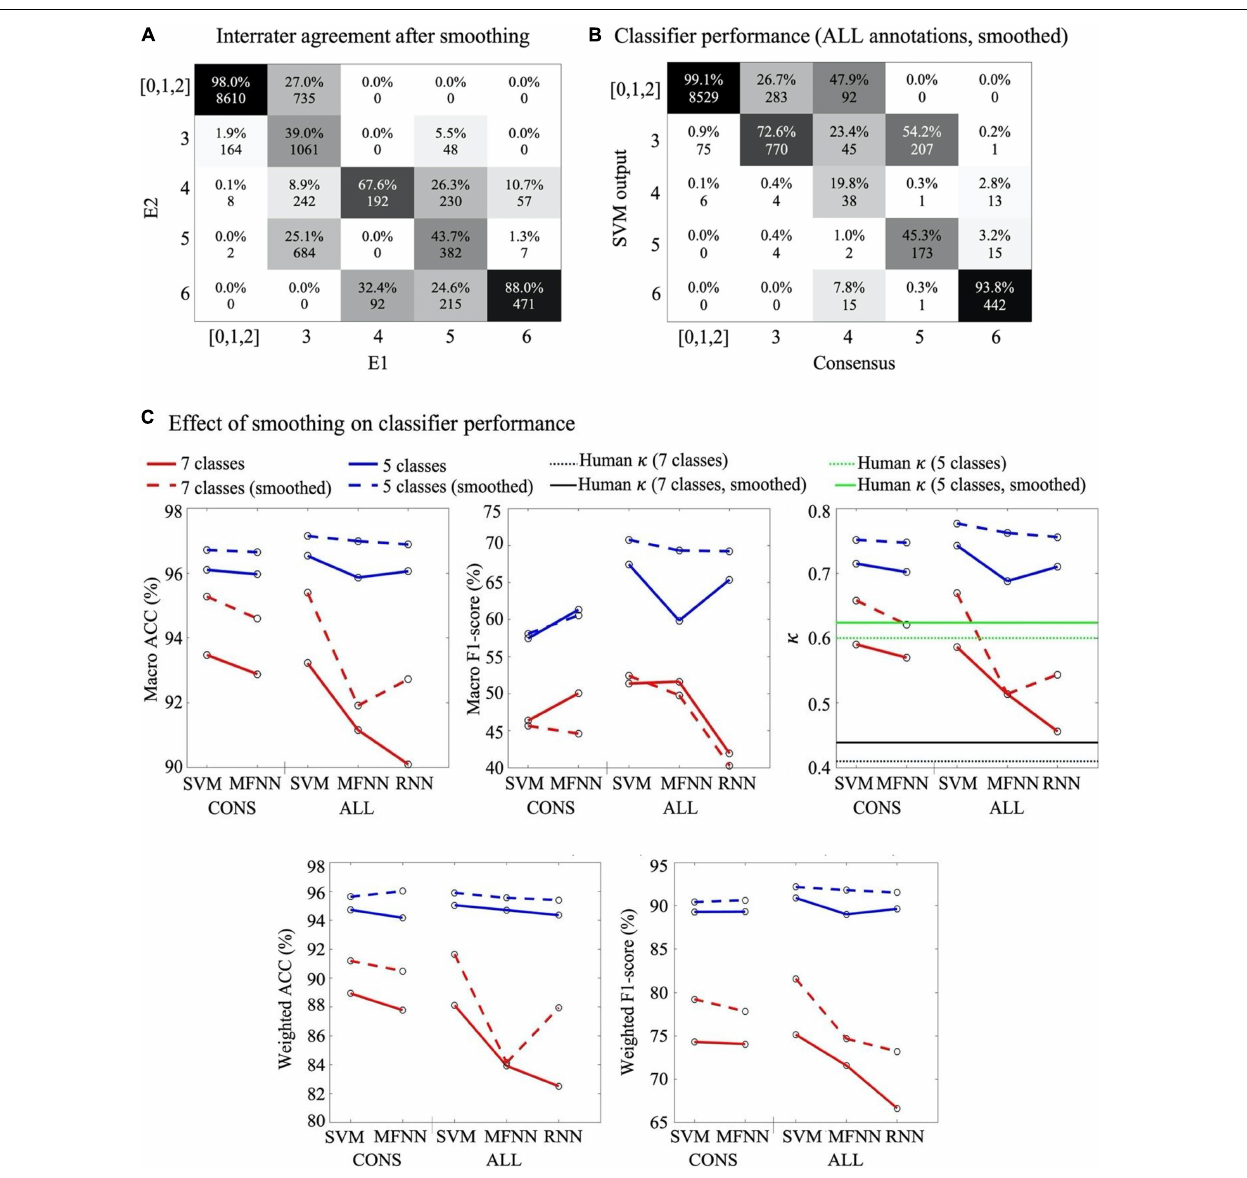
FIGURE 4 | Effects of post-processing. (A) Confusion matrix between experts 5-score scores after smoothing. Note the significant increase in agreement as compared to Figure 3 . (B) Confusion matrix for SVM classifier from ALL annotation approach based on 5-score with smoothing. (C) Comparison of classifiers’ performances without (solid line) and after with (stippled line) smoothing. Note the generally higher performance after smoothing. In the right most graph, the horizontal lines depict comparison to the human interrater agreement levels using 7-score ( κ = 0.41; black stippled line), smoothed 7-score ( κ = 0.44; black solid line), 5-score ( κ = 0.60; green stippled line), and smoothed 5-score ( κ = 0.62; green solid line),